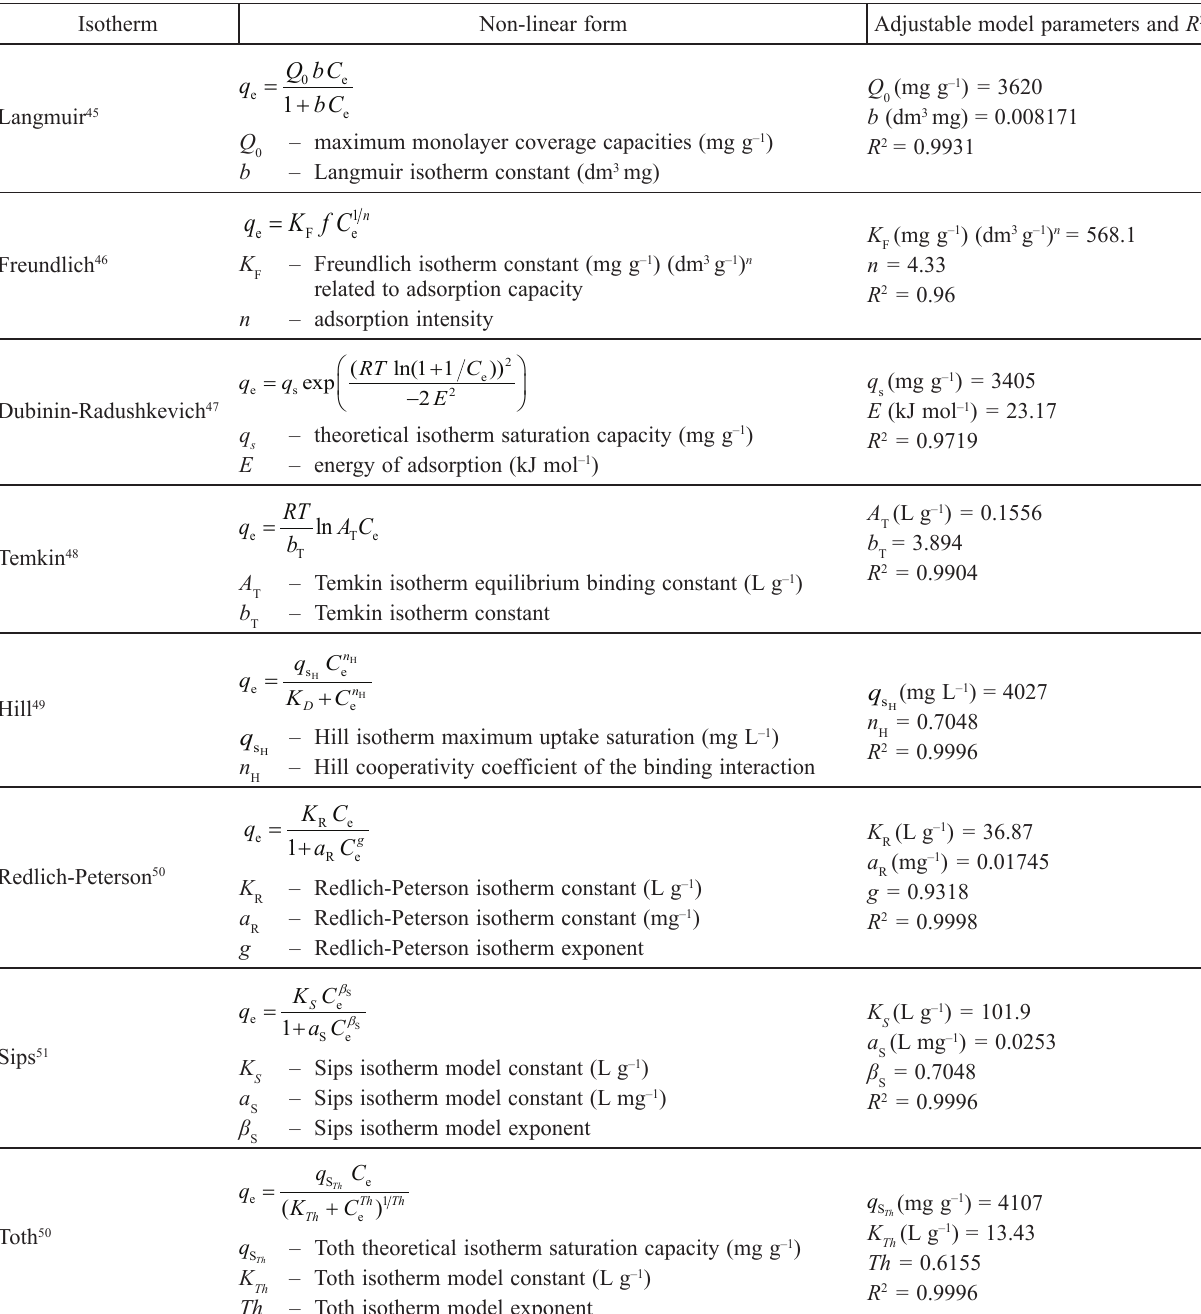
Table 3 – Expressions of non-linear adsorption isotherm models and the different parameters involved Isotherm Non-linear form Adjustable model parameters and R